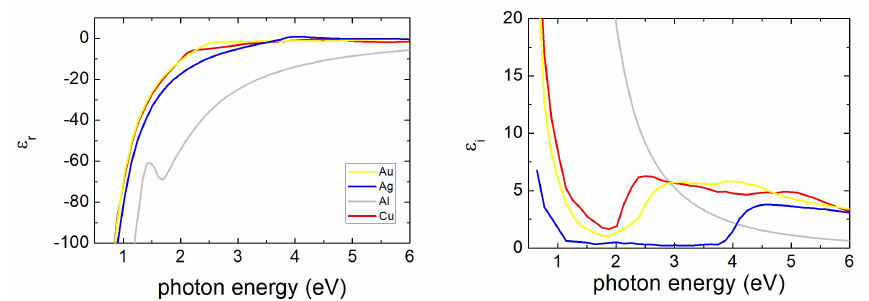
Figure 1. Real (left) and imaginary (right) parts of the dielectric function of Ag, Au, Cu (Reference [18]) and Al (Reference [6]) as function of photon